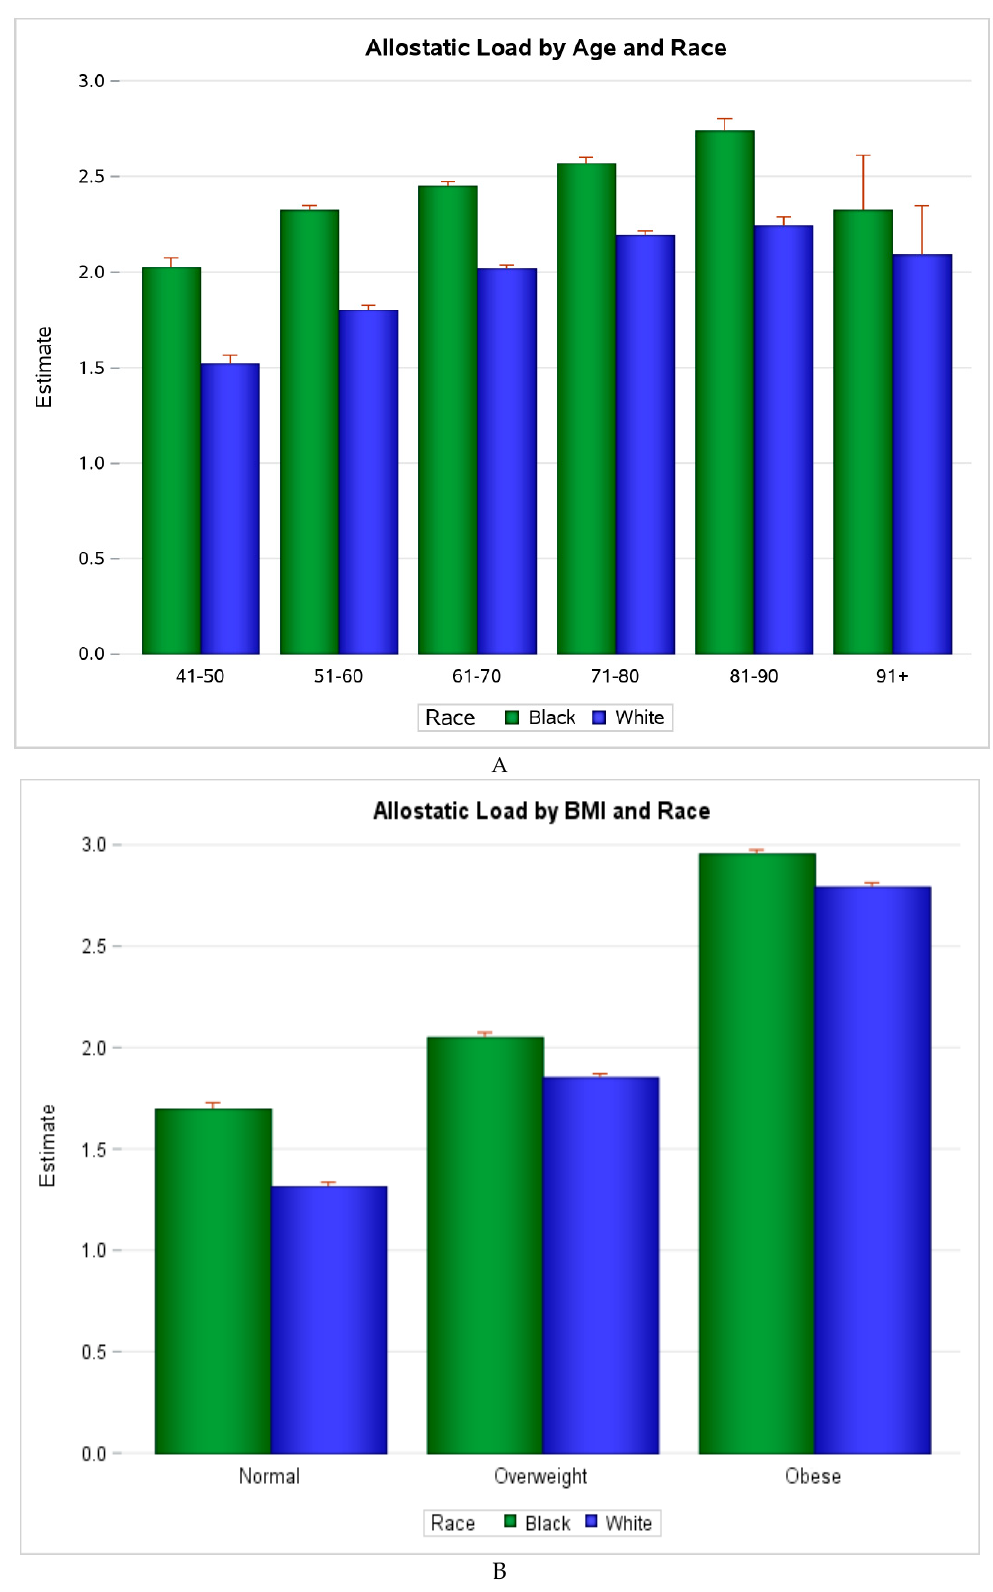
Figure 1. ( A ) Distribution of Allostatic Load Score in the REGARDS Cohort by Age and Race. ( B ). Distribution of Allostatic Load Score in the REGARDS Cohort by BMI and Race.